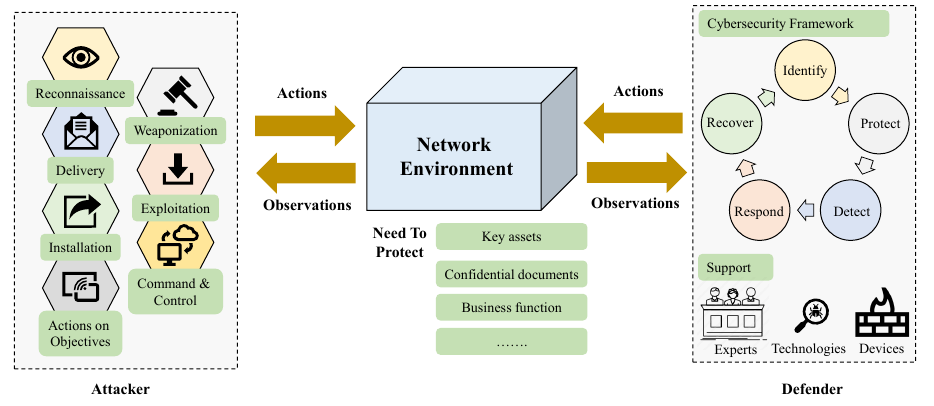
Figure 3. An example of the internal